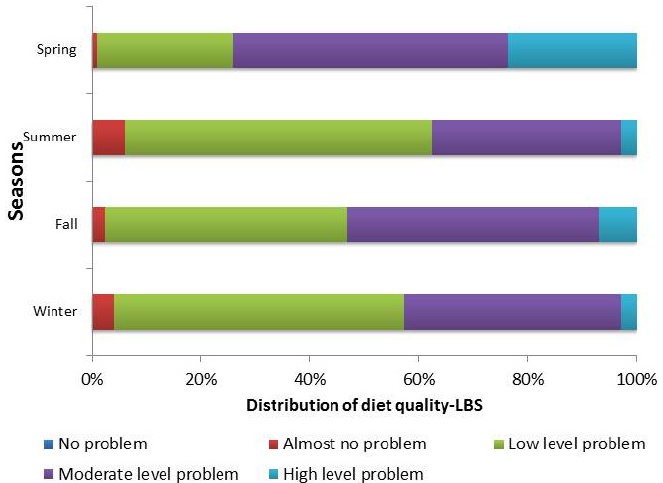
Figure 2. Distribution of the lower bound score (LBS) (Score range of LBS is 0–72; No problem: 0; Almost no problem: 1–14; Low level: 15–29; Moderate level: 30–43; High level: >43.